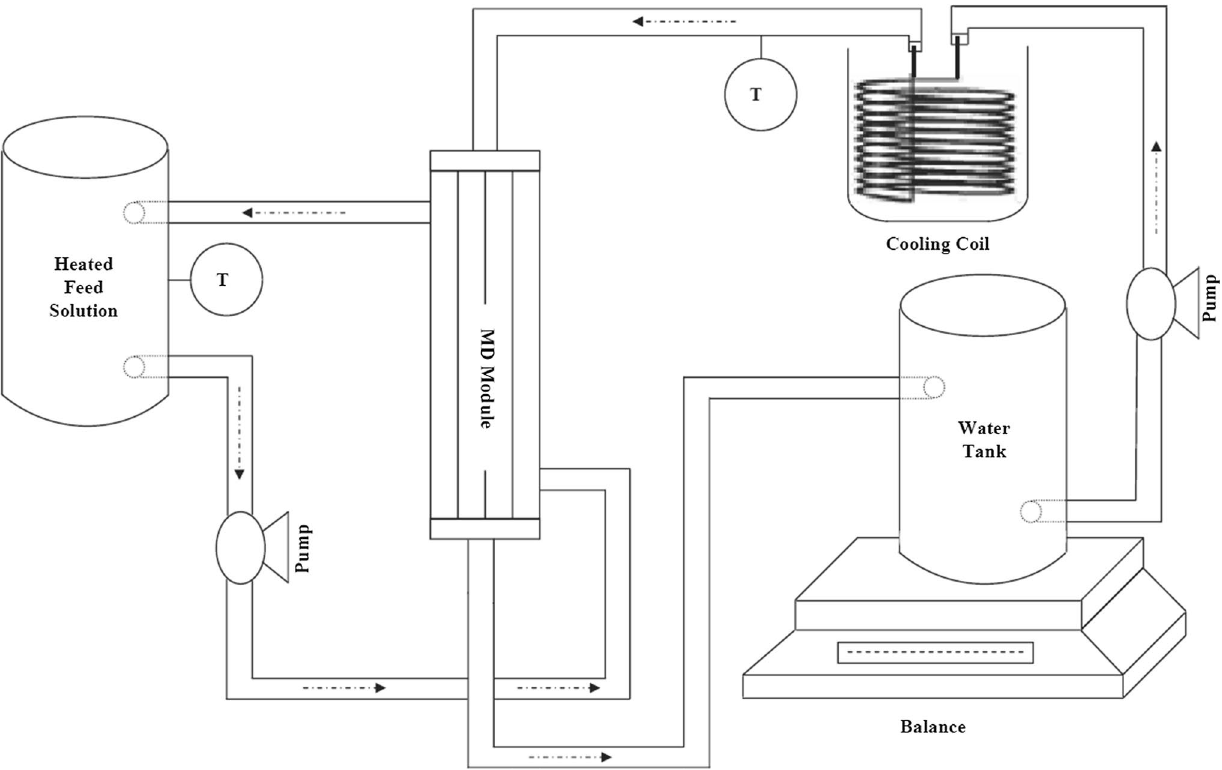
Fig. 3 DCMD experimental set-up (Osman et al.